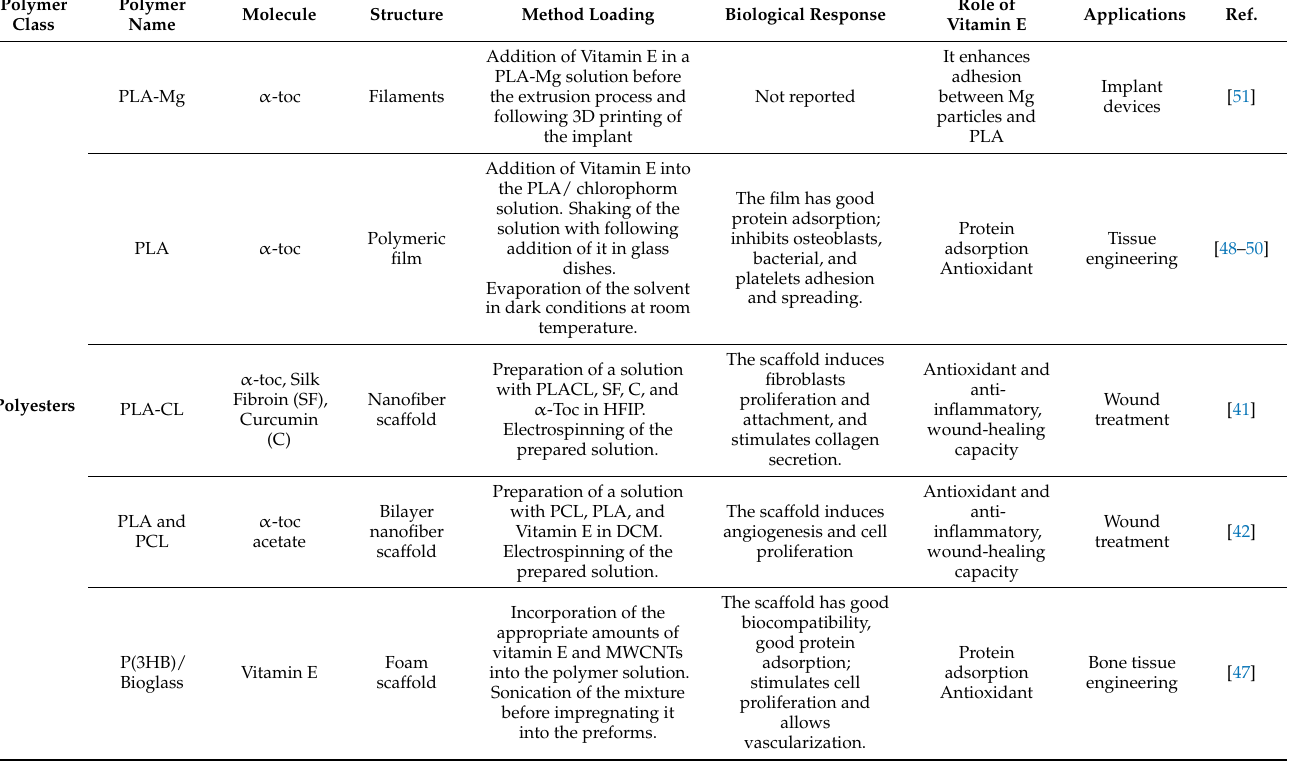
Table 2. Vitamin E in Tissue